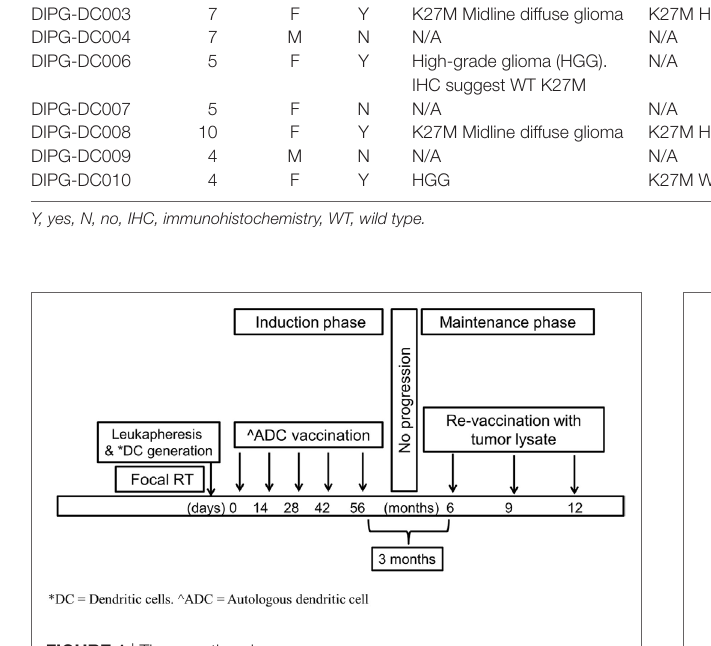
FiGUrE 1 | Therapeutic schema.